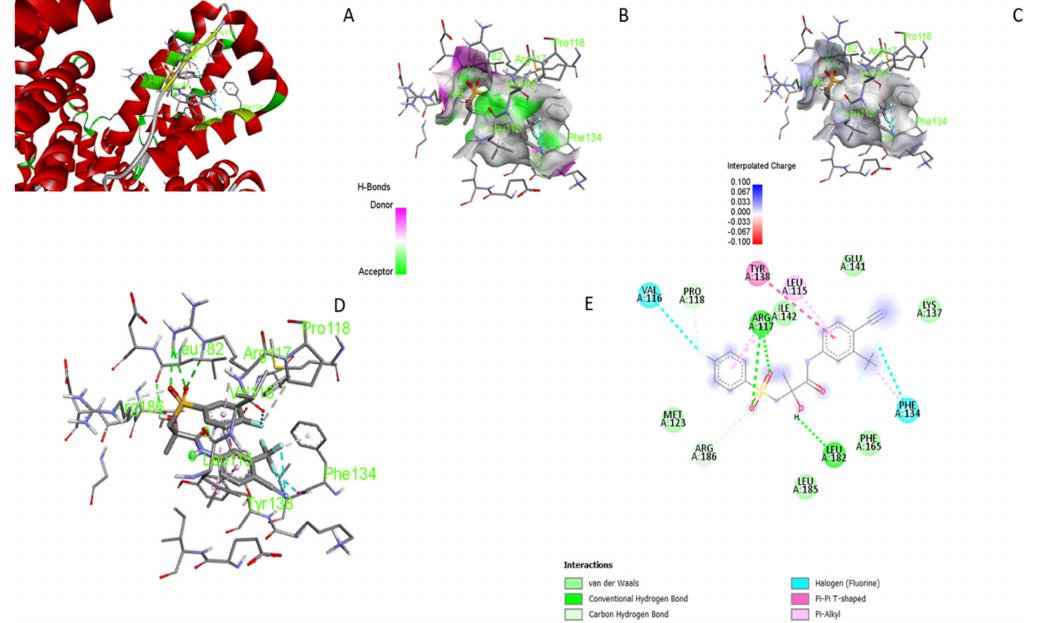
Figure 10. Three-dimensional representation of the interaction of BIC with the receptor ( A , D ). BIC, like PAZ, acts as both acceptor and donor and forms hydrogen bonds with the receptor ( B ). Therefore, BIC also interacts strongly with the receptor. The regions where BIC and the receptor interact are neutral ( C ). The close docking scores of BIC and PAZ were attributed to interactions with the PHE134 and VAL116 residues ( E ) formed through halogen (fluorine) bond, which is also a strong bond pi-sulfur double bond observed in